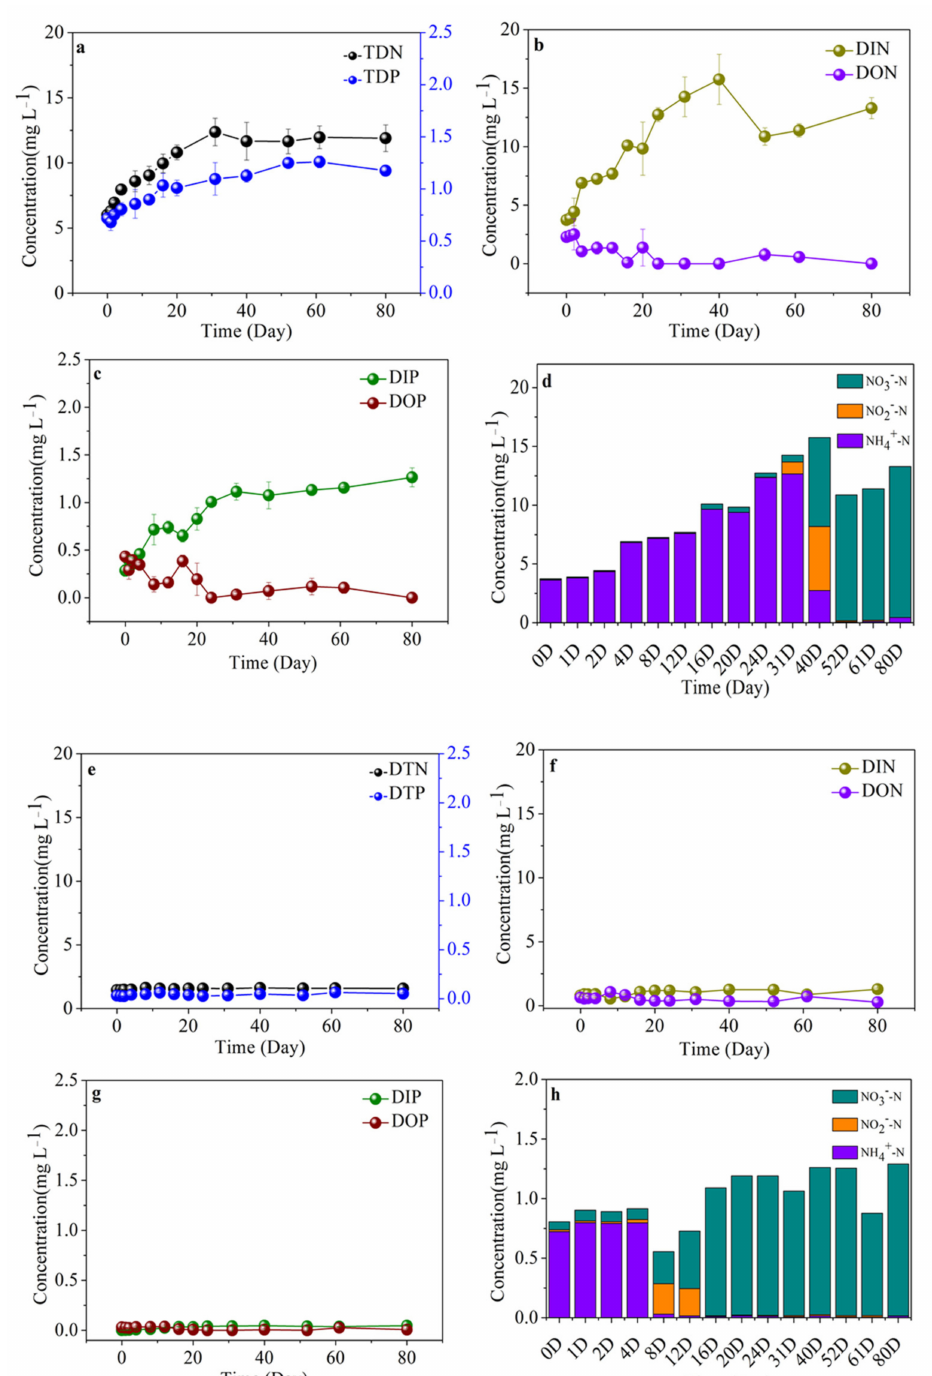
Figure 8. Variations in dissolved nitrogen and phosphorus concentrations and compositions during the 80-d degradation processes of the ( a – d ) bulk algal-derived dissolved organic matter (DOM) group and ( e – h ) natural lake water group (as control). TDN—total dissolved nitrogen, TDP—total dissolved phosphorus, DIN—dissolved inorganic nitrogen, DON—dissolved organic nitrogen, DIP—dissolved inorganic phosphorus, DOP—dissolved organic phosphorus, DTP—dissolved total phosphorus, DTN—dissolved total